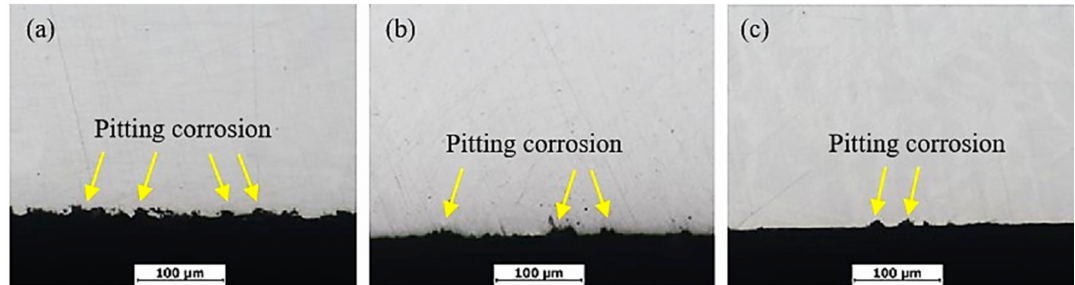
Figure 10. Cross section morphology of intergranular corrosion for the welded joints under different shielding